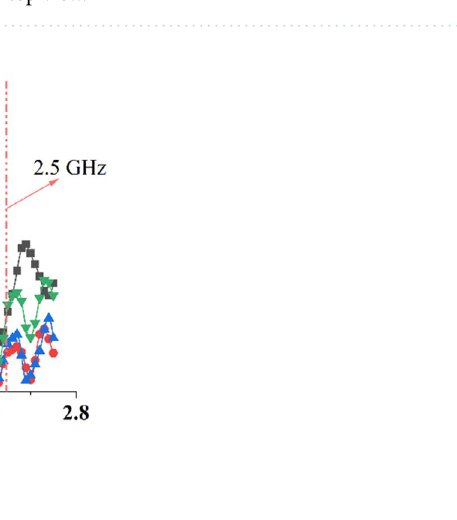
Figure 13. Scale model of the transmitting antenna array. ( a ) Simulation model, ( b ) perspective view of the fabricated model, ( c ) front view, ( d ) back view, and ( e ) top view.